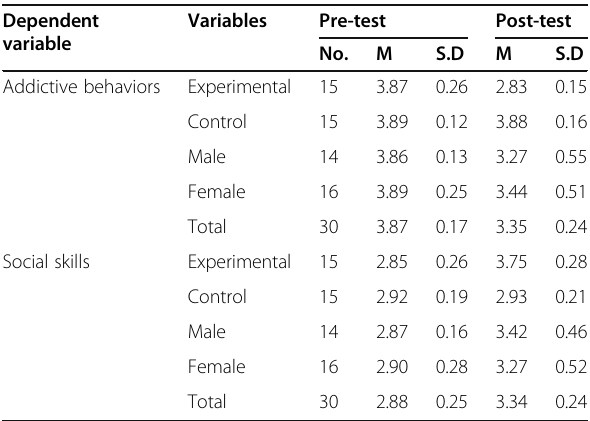
Table 2 Means and standard deviations for study variable on pre- and